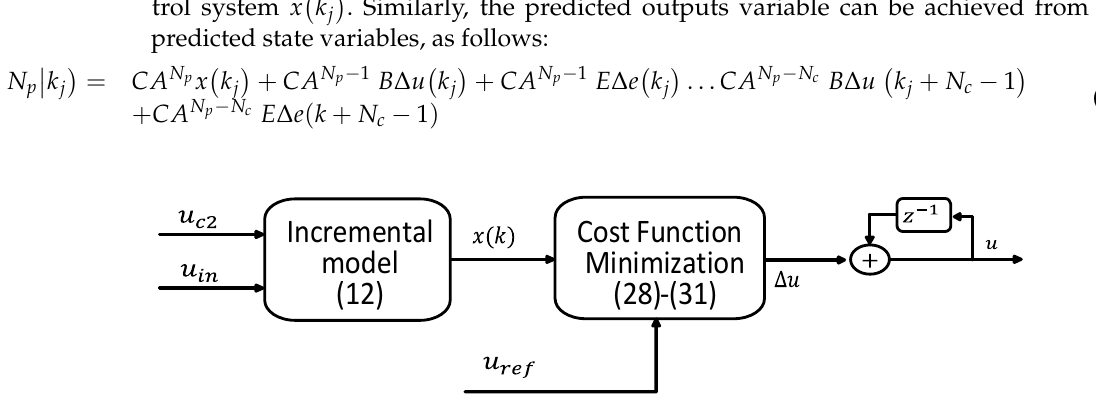
Figure 3. Control block diagram of CCS-MPC.